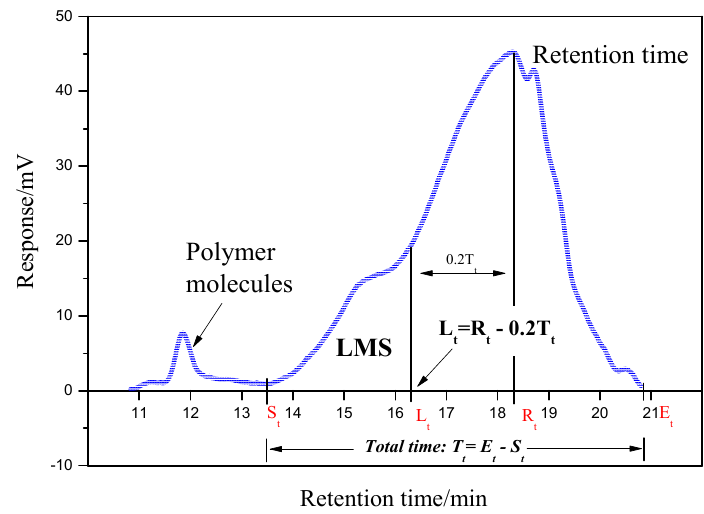
Figure 1. Gel permeation chromatography (GPC) analysis diagram of bitumen. 38